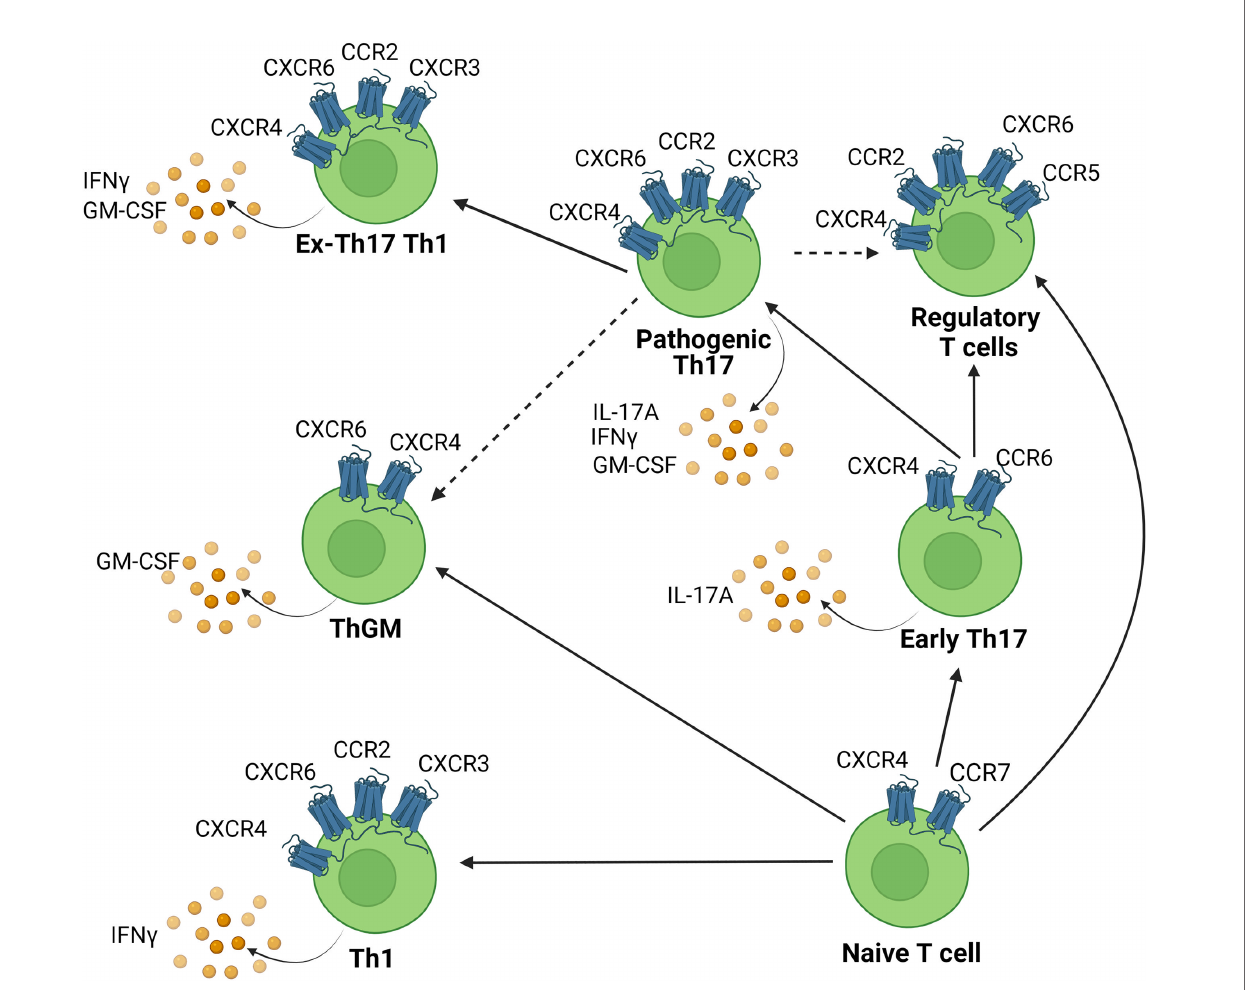
FIGURE 2 | Chemokine receptor expression on CNS in fi ltrating Th cell subsets. Chemokines attract chemokine receptor expressing Th cells to in fi ltrate the CNS. Various Th subsets are capable of migration into the CNS to cause in fl ammation. This includes Th1, Th17, ThGM cells and each are associated with distinct chemokine receptor signatures. Solid lines indicate pathways of cellular transdifferentiation. Dotted lines indicate potential pathways that remain to be elucidated. Figure was created using